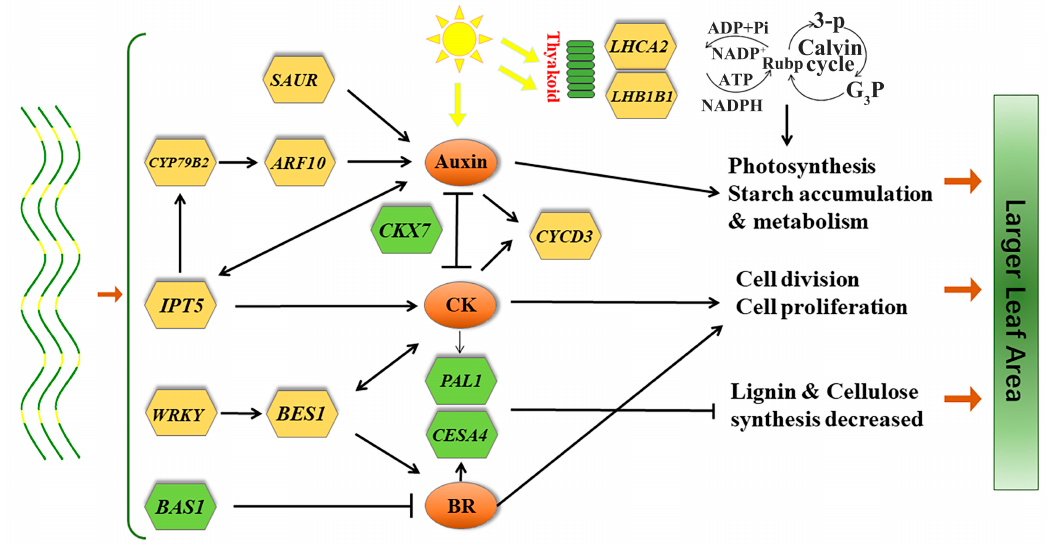
Figure 5. Mechanism model of triploids in forming giant leaves. The yellow hexagons and red ovals represent upregulated in triploids; green hexagons represents downregulated in triploids. Arrows are for facilitation and transversals are for inhibition. Supplementary Materials: The following are available online at http: // www.mdpi.com / 1999-4907 / 10 / 10 / 920 / s1, Figure S1: Sampling schematic, Table S1: The primer sequences for real time-PCR; Table S2: The gene expression level in each sample; Table S3: List of di ff erentially expressed genes and function categories between Triploid and Diploid at 04:00; Table S4: List of di ff erentially expressed genes and function categories between Triploid and Diploid at 09:00; Table S5: List of di ff erentially expressed genes and function categories between Triploid and Diploid at 21:00.